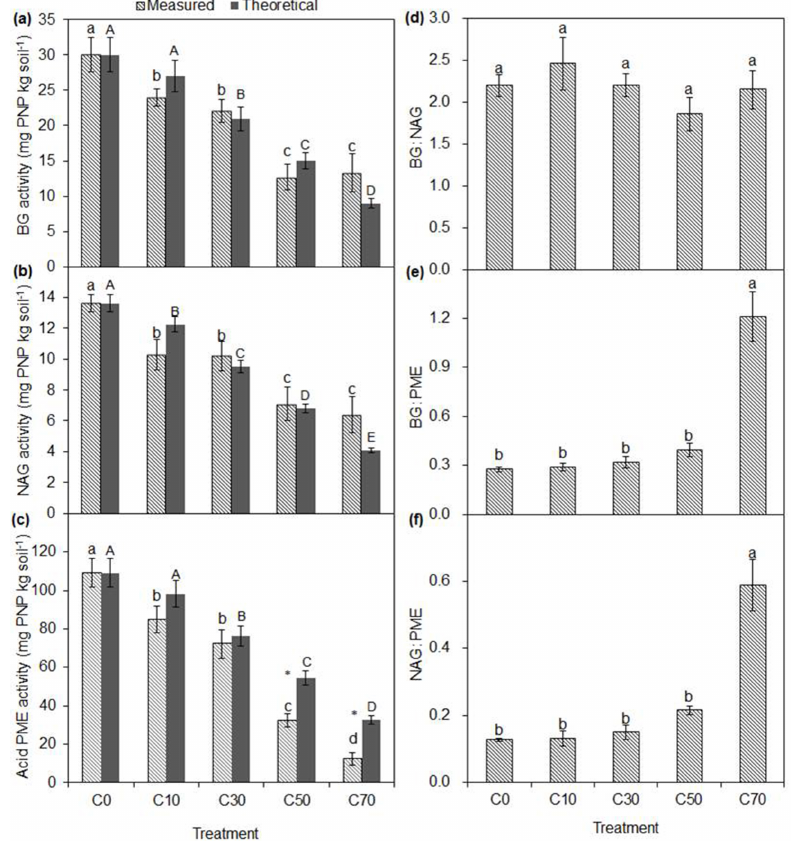
Figure 5. Changes in (a) activities of soil β -glucosidase (BG), (b) N-acetyl-glucosaminidase (NAG), (c) acid phosphomonoesterase (PME), (d) the ratio of BG:NAG, (e) BG:PME, and (f) NAG:PME as affected by different degrees of soil coarseness: 0% sand addition (C0), 10 (C10), 30 (C30), 50 (C50), and 70% (C70). Dashed bars represent values obtained from laboratory measurements, while black bars are values calculated from theoretical dilution. Data represent mean ± standard error ( n = 6). Letters indicate significant differences among treatments. Asterisks indicate significance between values from laboratory measurements and theoretical values accounting for dilution within one treatment. Table 1. Regression statistics relating soil physicochemical properties and microbial parameters. SOC TN <250µm pH DOC TDN Olsen-P Multiple MBC 0.59 0.65 0.76 ∗∗ − 0.67 0.52 – – 0.76 MBN 0.50 0.56 0.58 − 0.73 ∗∗ 0.43 – – − 0.73 MBP – – – – – – − 0.40 ∗ − 0.40 BG 0.79 0.80 ∗∗ 0.74 − 0.73 0.73 0.54 – 0.80 NAG 0.69 0.72 ∗∗ 0.70 − 0.68 0.60 0.45 – 0.72 PME 0.90 0.86 0.60 –